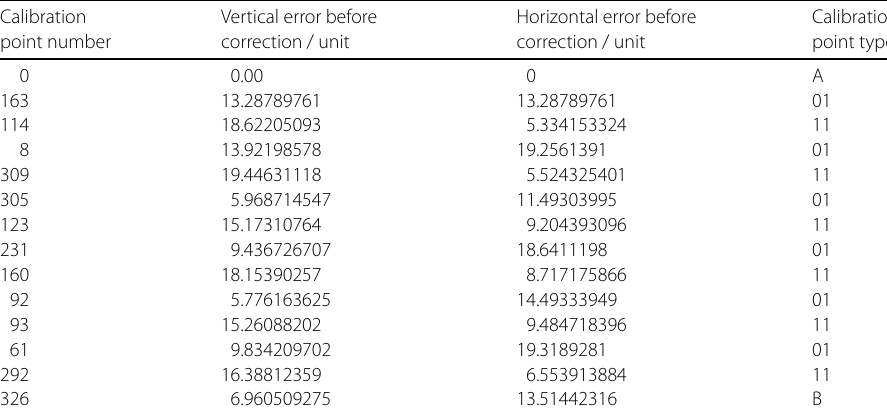
Table 4 Data set 2 route planning table Calibration point number